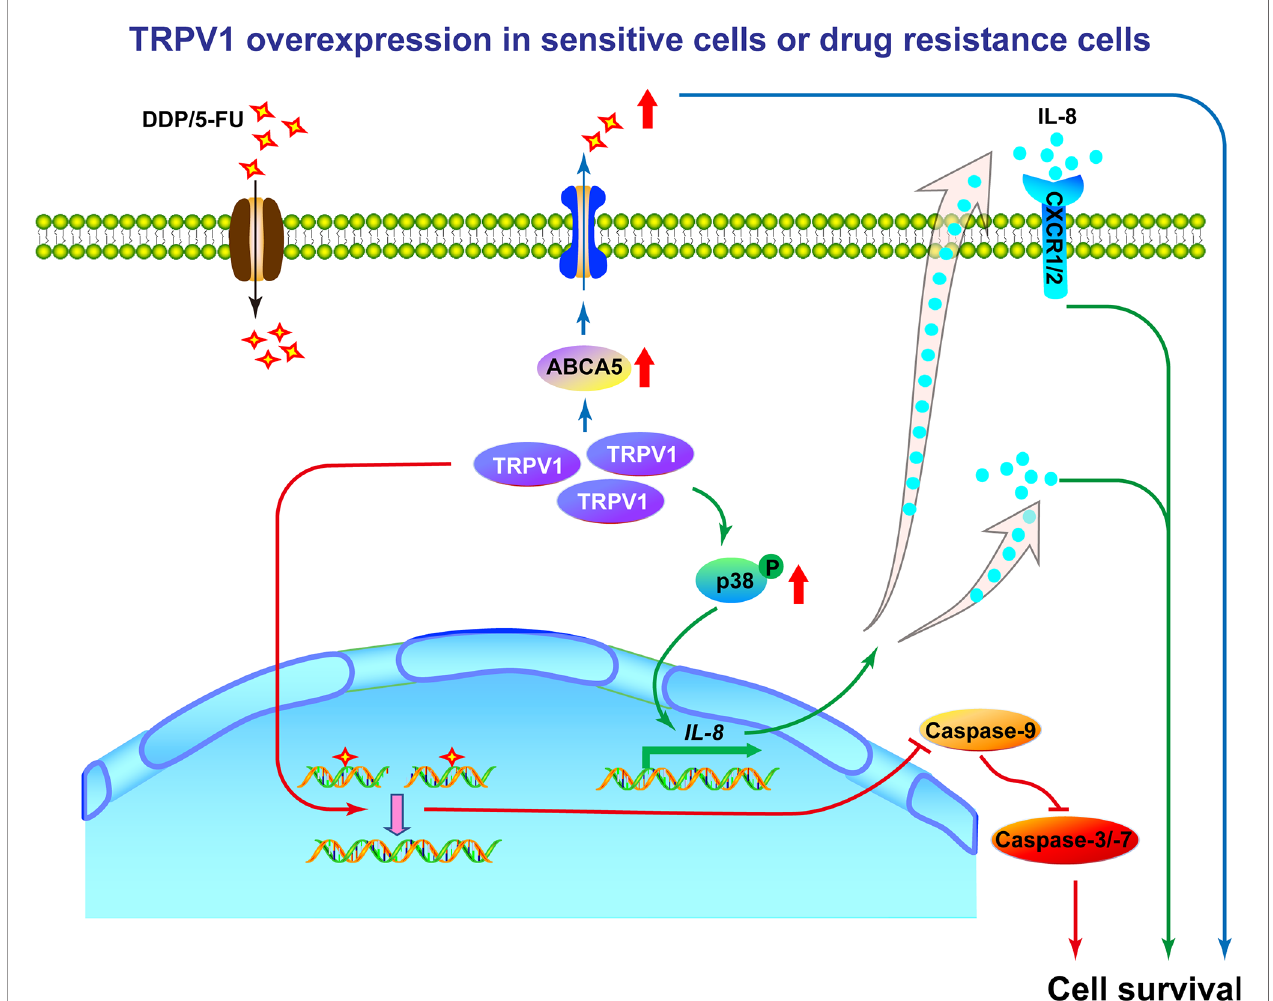
FIGURE 9 | Working model of the mechanism by which TRPV1 regulates chemoresistance in A549 cells. In sensitive NSCLC cells, DDP or 5-FU induces DNA damage, resulting in cell death. In DDP/5-FU sensitive cells with TRPV1 overexpression and in DDP/5-FU resistant cells, high levels of TRPV1 increase ABCA5 drug transporter expression resulting in increased drug ef fl ux, enhances HR DNA repair ef fi ciency subsequently leading to cell apoptosis inhibition, activates the p38 MAPK signaling pathway and increases IL-8 secretion to promote cell survival. Through the above three ways, TRPV1 fi nally induces chemoresistance. In addition, partial of IL-8 induces chemoresistance via CXCR1/2